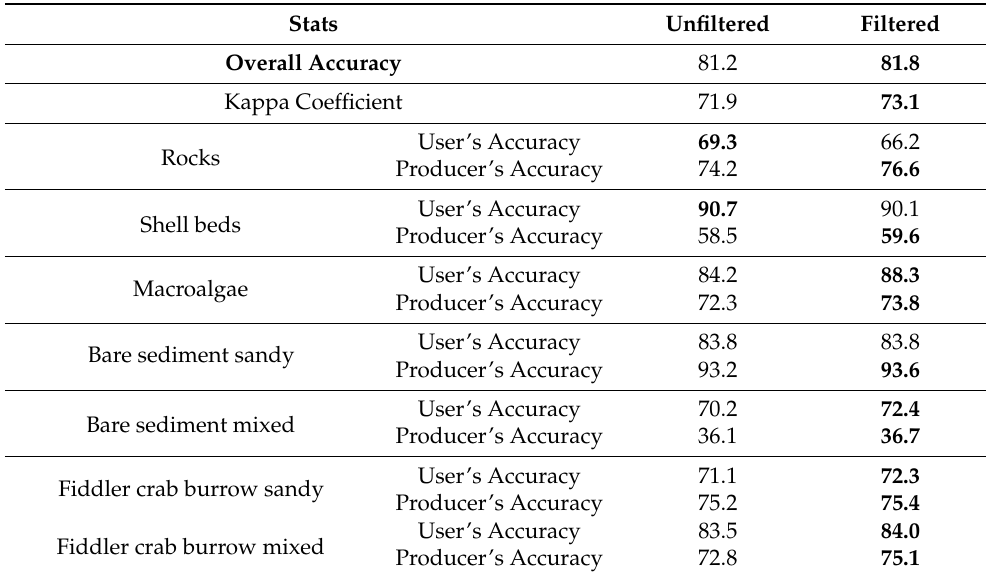
Table 4. Comparison of independent validation statistics between unfiltered and filtered intertidal habitat distribution maps, produced from the prediction made with the final random forest model with the 14 best predictors. Numbers in bold signal the highest